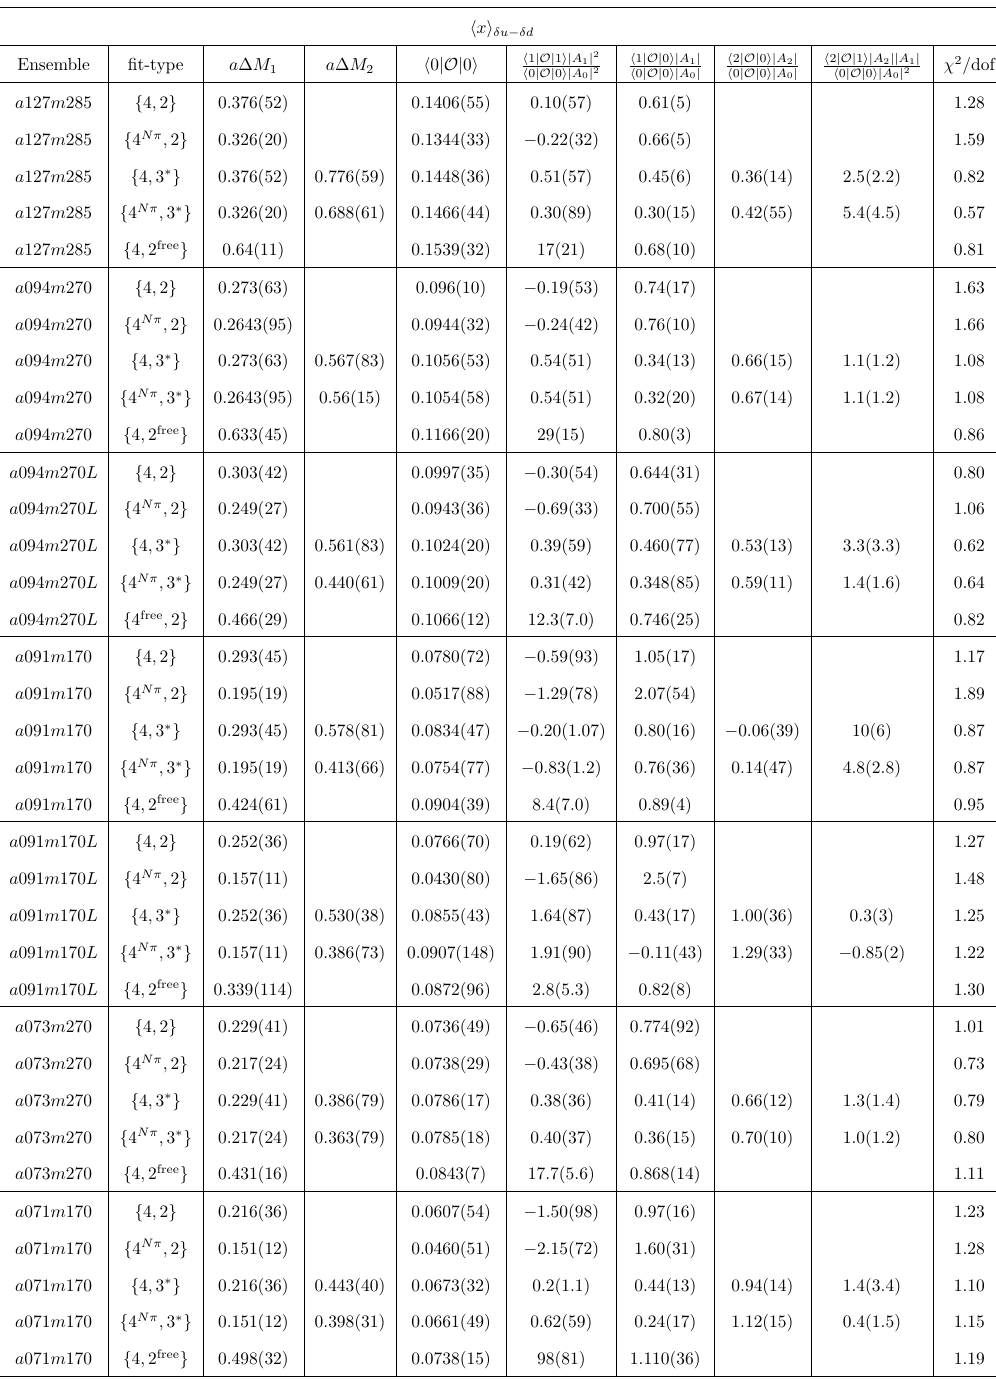
Table 9 . Comparison of results of the fits to remove the excited-state contamination for the transversity moment h x i . The rest is the same as in table δu − δd